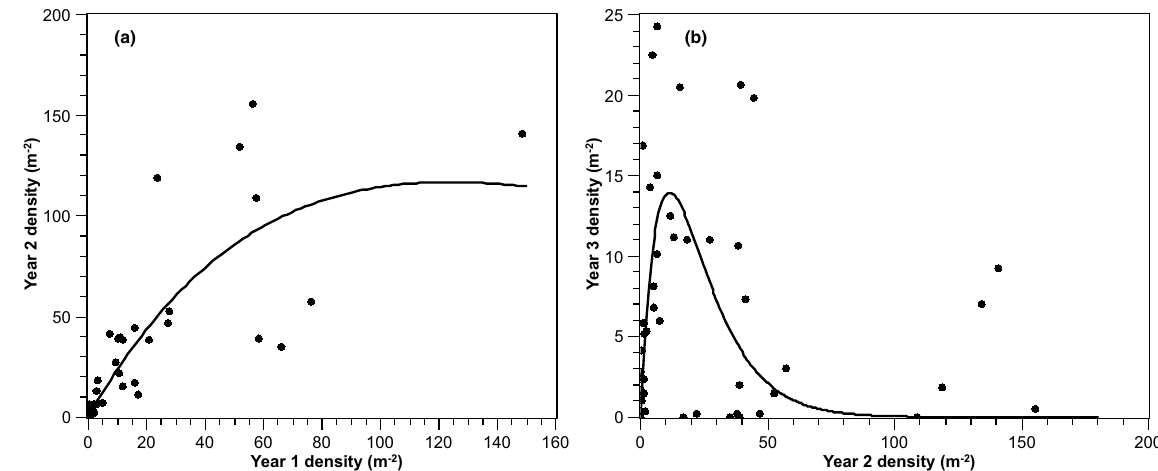
Fig. 3. (a) Relationship between the density of L. littorea in the second size class and the fi rst (smallest, year 1) size class. Fitted relationship is a Ricker curve ( r 2 = 67%). Each point represents the density estimate from a 30 m wide transect covering the intertidal where L. littorea were found. (b) Relationship between the densities of the largest (third year) size class and the second size class for individual transects. The line is a fi tted Ricker curve ( r 2 =19%).